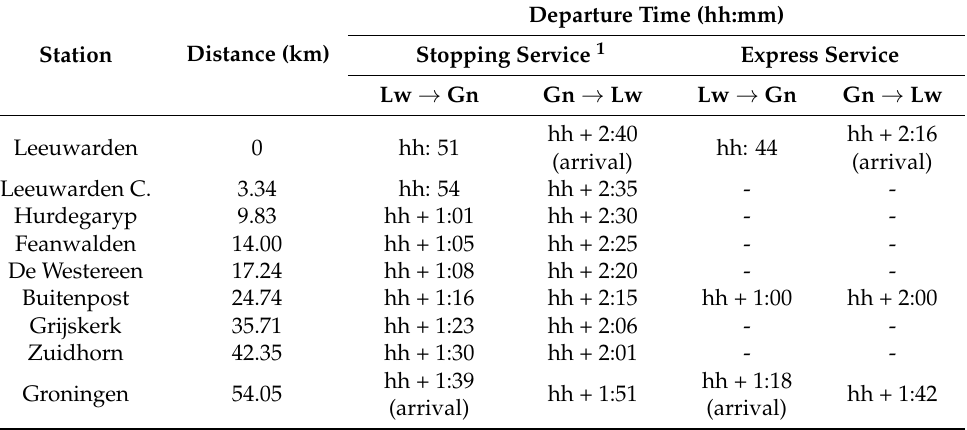
Table 3. Distance between stops and departure times for the line Leeuwarden (Lw) to Groningen